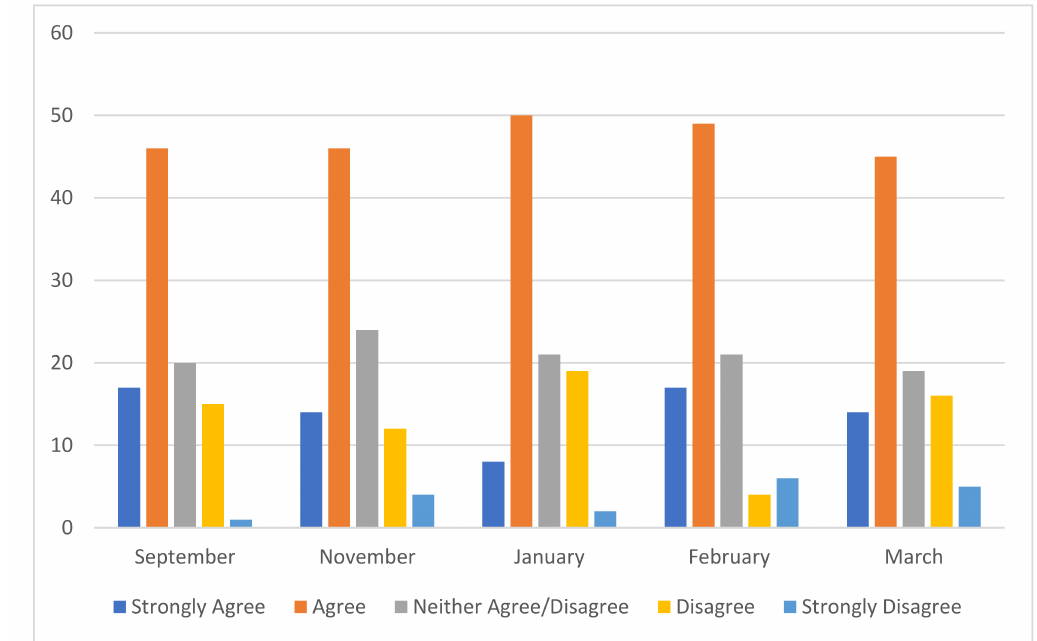
Figure 4. Impact on Mental Health of Carer: 5 rating scale to ‘My own mental health is being impacted by caring/supporting for someone with an ED’ ( n =